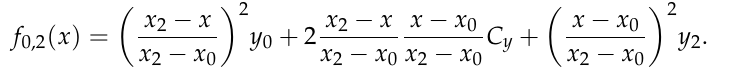
) , ( C x , C y ) and ( x ) is highlighted 0 , y 0 2 , y 2